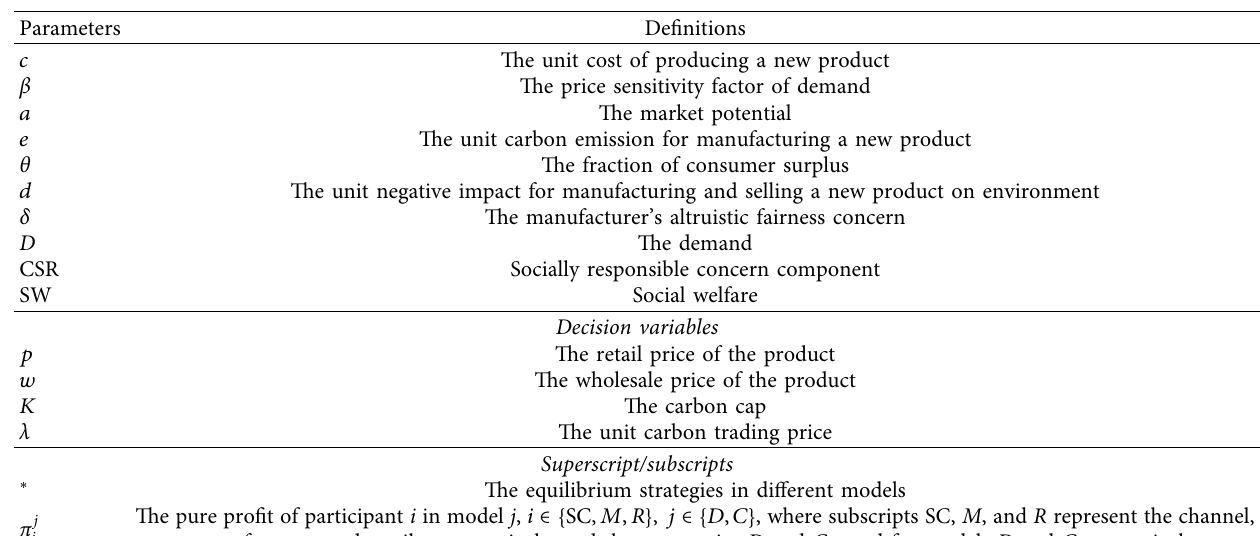
Table 2: List of